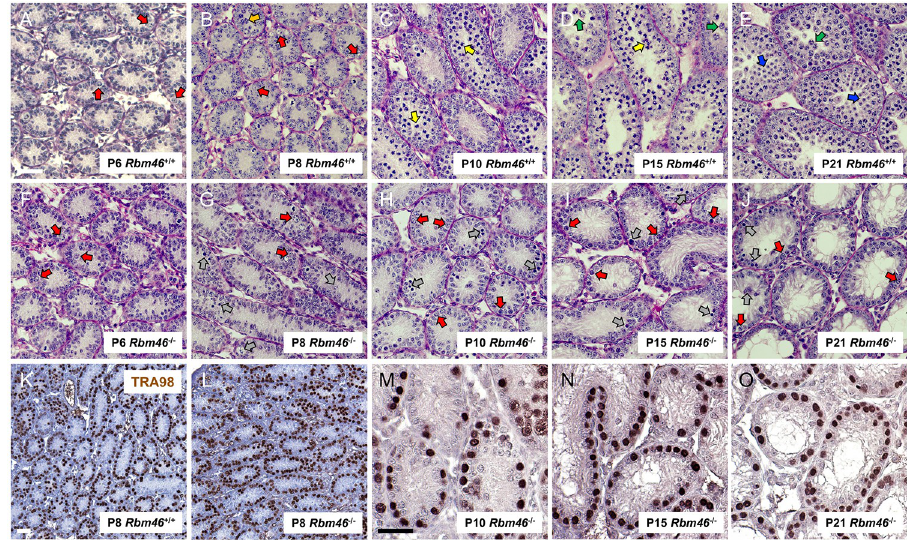
stained Rbm46 +/+ testes. These include spermatogonia (red arrows), preleptotene spermatocytes (orange arrows), leptotene spermatocytes (yellow arrows), pachytene spermatocytes (green arrows), and round spermatids